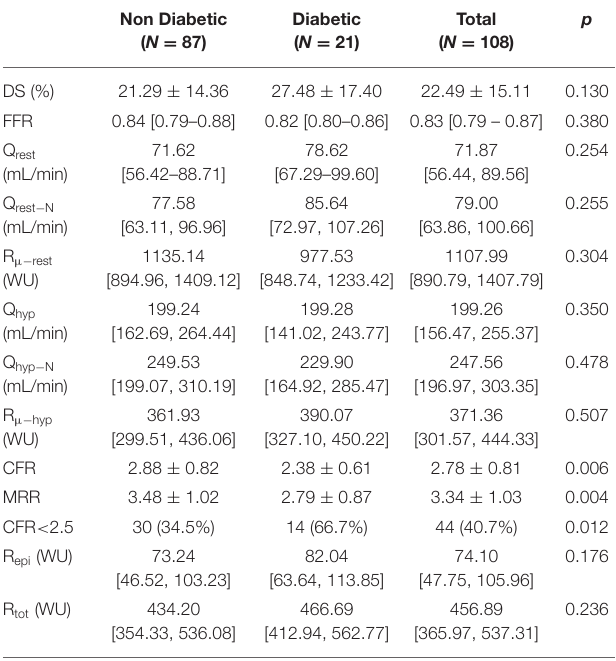
TABLE 2 | Angiographic and hemodynamic